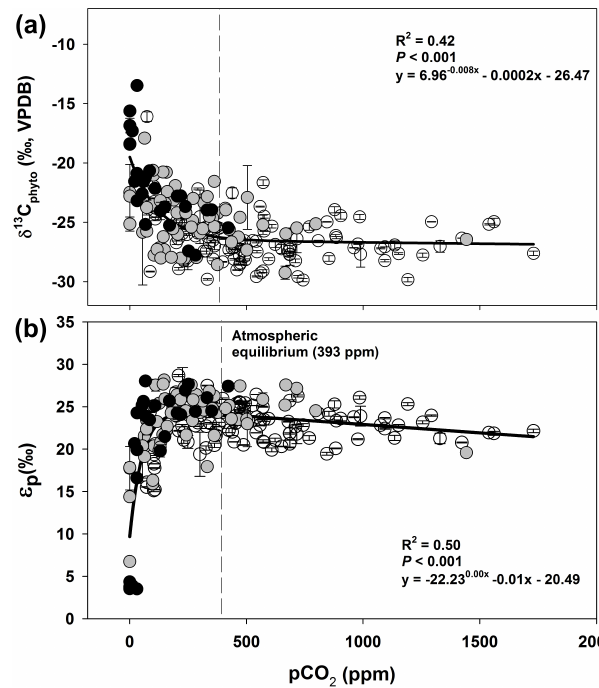
Figure 4. (a) Nonlinear relationship between the stable isotopic ambient p CO 2 concentration in surface water and the stable car- bon isotopic signature of the phytoplankton community. (b) Nonlin- ear relationship between photosynthetic fractionation ( ε p ; biomass relative to ambient CO 2 ) and p CO 2 . The vertical line indicates atmospheric equilibrium when samples were collected (393ppm). The color of the points indicates Chl a concentration: white = 0– 40µg Chl a L − 1 ; grey = 41–100µg Chl a L − 1 ; black = >100µg Chl a L − 1 . The vertical line indicates atmospheric CO 2 equilibrium when the study was conducted (393ppm).